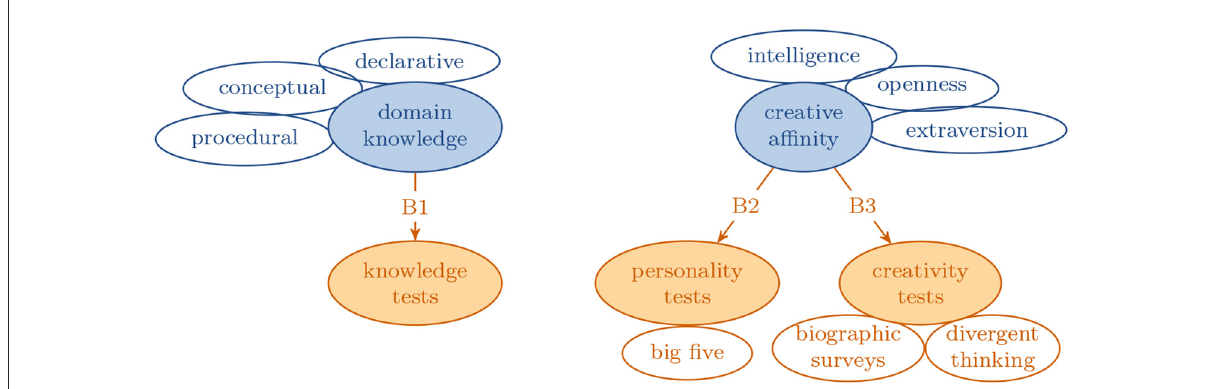
FIGURE3 A closer look at the person plate. This plate includes variables describing the creative capacity of a single student. We provide examples of such variables from the literature in transparent nodes. Citations: B1 (Hayes, 1989; Sternberg, 2005; Mumford et al., 2011; Schubert and Loderer, 2019), B2 (Eysenck, 1993; Sung and Choi, 2009; Karwowski et al., 2013; Jauk et al., 2014), B3 (Torrance, 1972; Hocevar, 1979; Williams, 1980; Diedrich et al.,